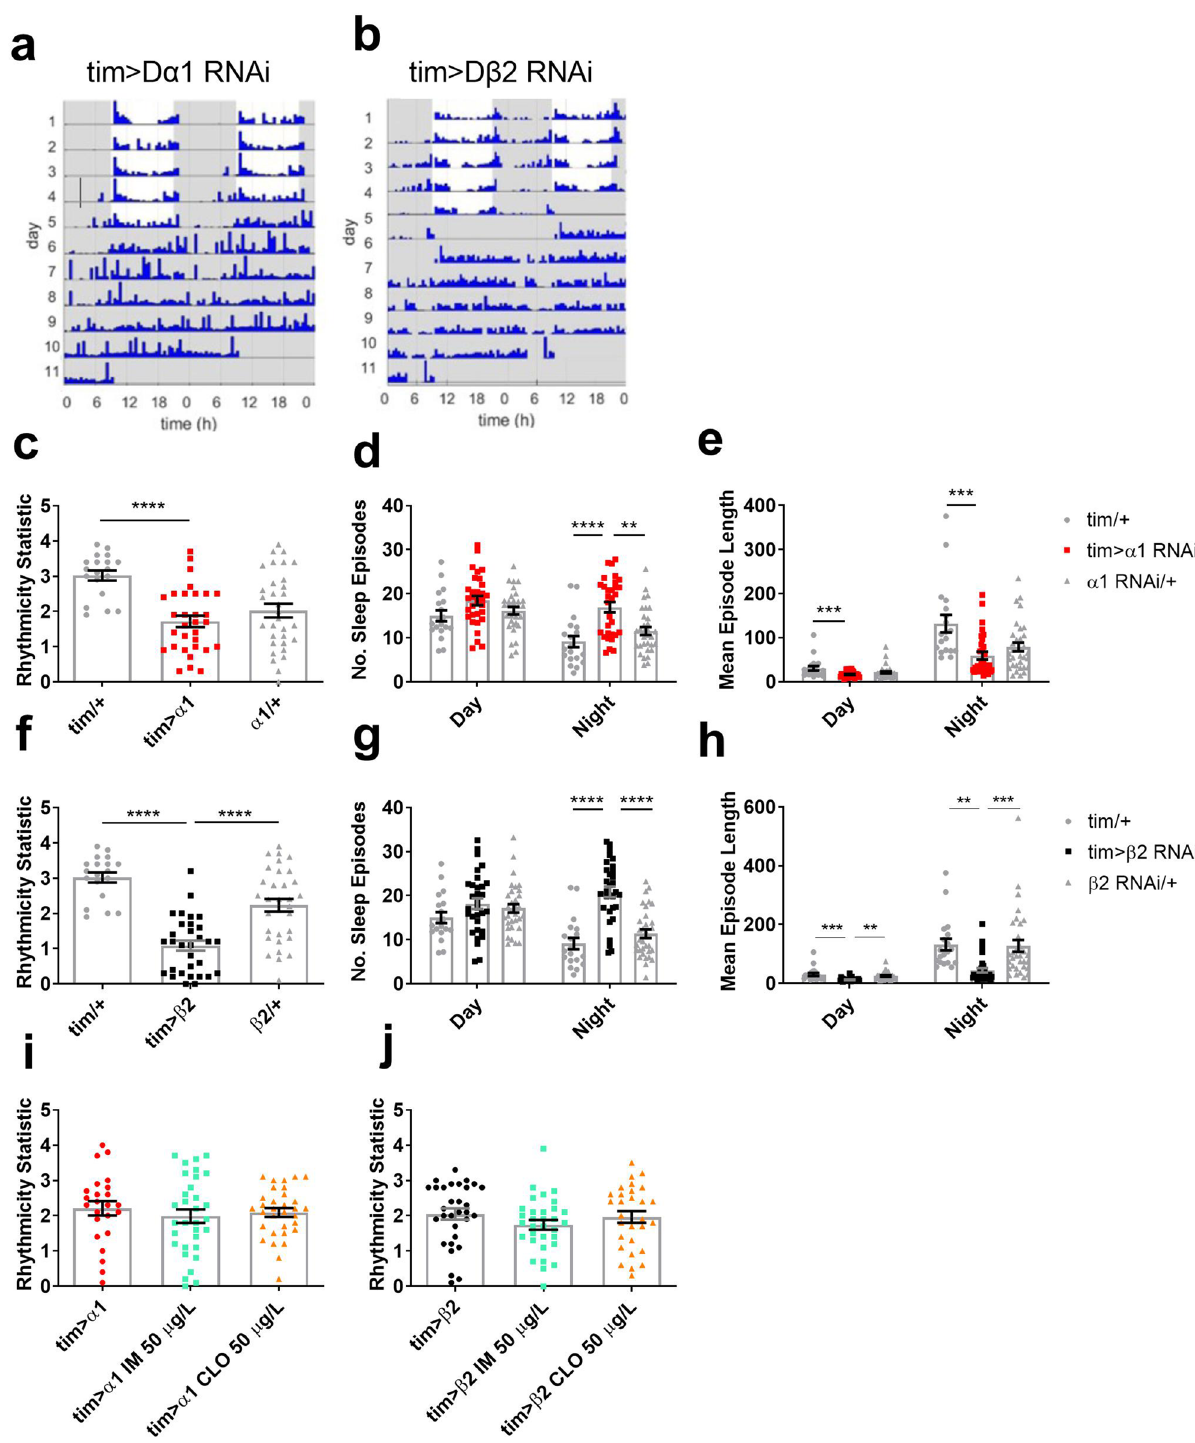
Figure 4. Knockdown of Dα1 or Dβ2 in the clock bearing cells disrupts circadian rhythmicity and sleep with no further effect by addition of neonicotinoids. Representative actograms for ( a ) Dα1 knock down ( tim- Gal4 > uas-nAChR-Dα1 ) and ( b ) Dβ2 knockdown ( tim-Gal4 > uas-nAChR-Dβ2. Effects of knocking down Dα1 in clock bearing cells on ( c ) rhythmicity (RS) ( F 2,79 = 11.8, p < 0.001), ( d ) number (no.) of sleep episodes in day ( F 2,79 = 2.9, p = 0.063) and night ( F 2,79 = 12.3, p < 0.001) and ( e ) mean episode length in day ( F 2,79 = 5.1, p = 0.008) and night ( F 2,79 = 8.3, p = 0.001). Effects of knocking down Dβ2 in clock bearing cells on ( f ) rhythmicity ( F 2,79 = 31.5, p < 0.001), ( g ) no. of sleep episodes in day ( F 2,79 = 1.6, p = 0.211) and night ( F 2,79 = 28.2, p < 0.001) and ( h ) mean episode length in day ( F 2,79 = 11.2, p < 0.001) and night ( F 2,79 = 9.4, p < 0.001). Each data point represents a single fly, n = 19–32 flies per treatment. There was no additive effect of 50 µg/L of IM and CLO on ( i ) tim > α1 ( F 2,85 = 0.4, p = 0.677) and ( j ) tim > β2 ( F 2,89 = 1.1, p = 0.336). Each data point represents a single fly, n = 24–32 flies per